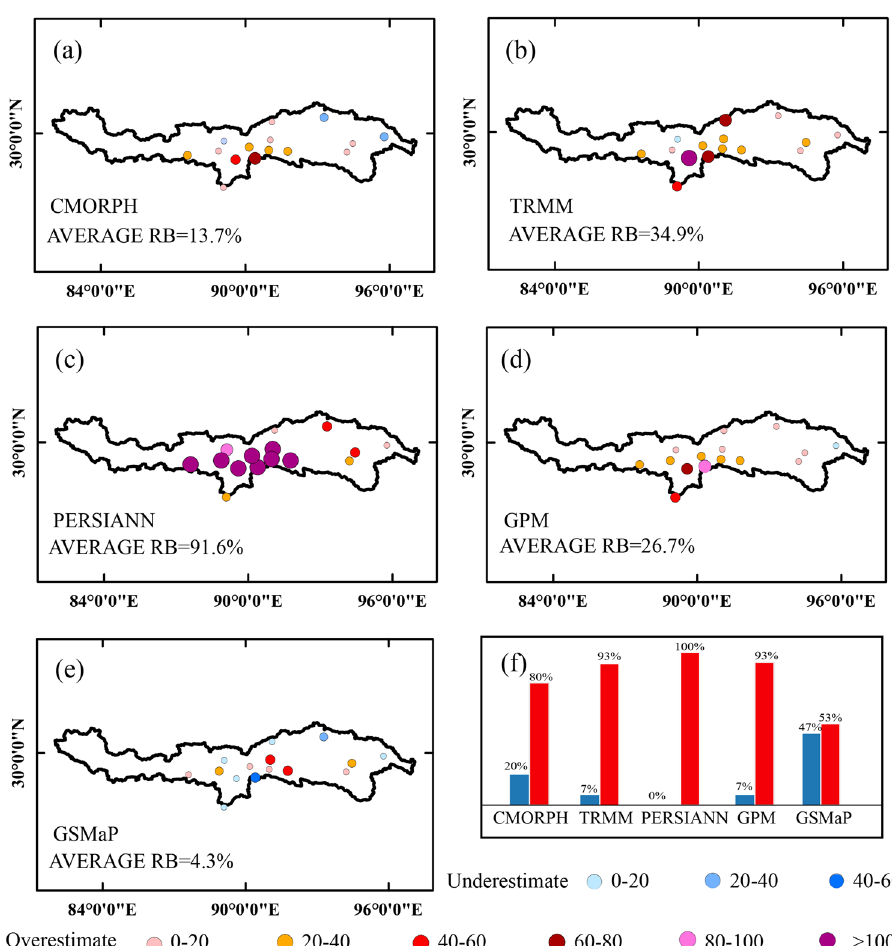
Figure 2. Relative Bias for ( a ) CMORPH, ( b ) TRMM, ( c ) PERSIANN, ( d ) GPM and ( e ) GSMaP and ( f ) fractions of underestimation (blue bar, %) and overestimation (red bar,%) stations against multi-year average gauged precipitation observations from 2003 to 2015 over